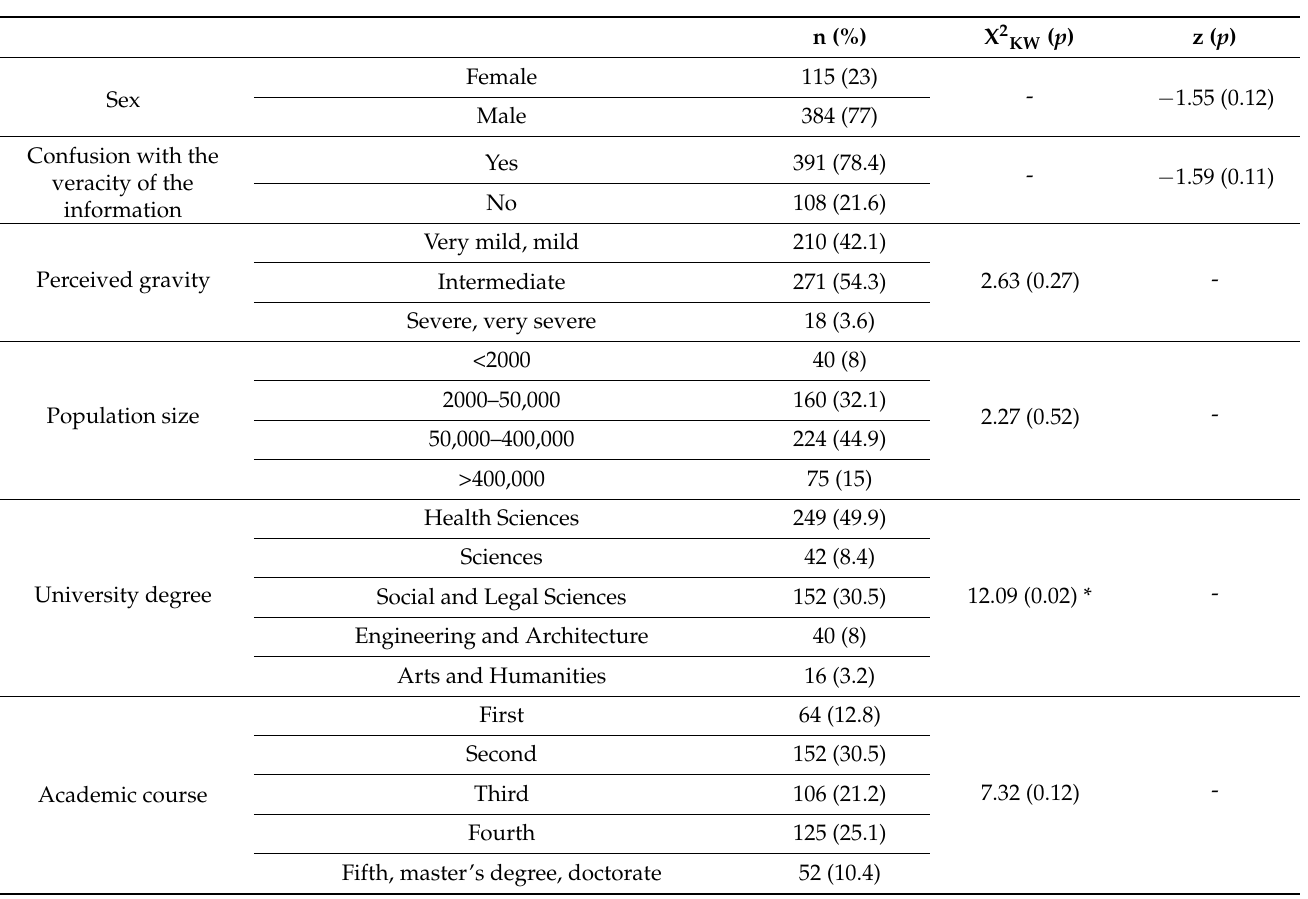
Table 2. Categorical variables. Correlations with HLC.